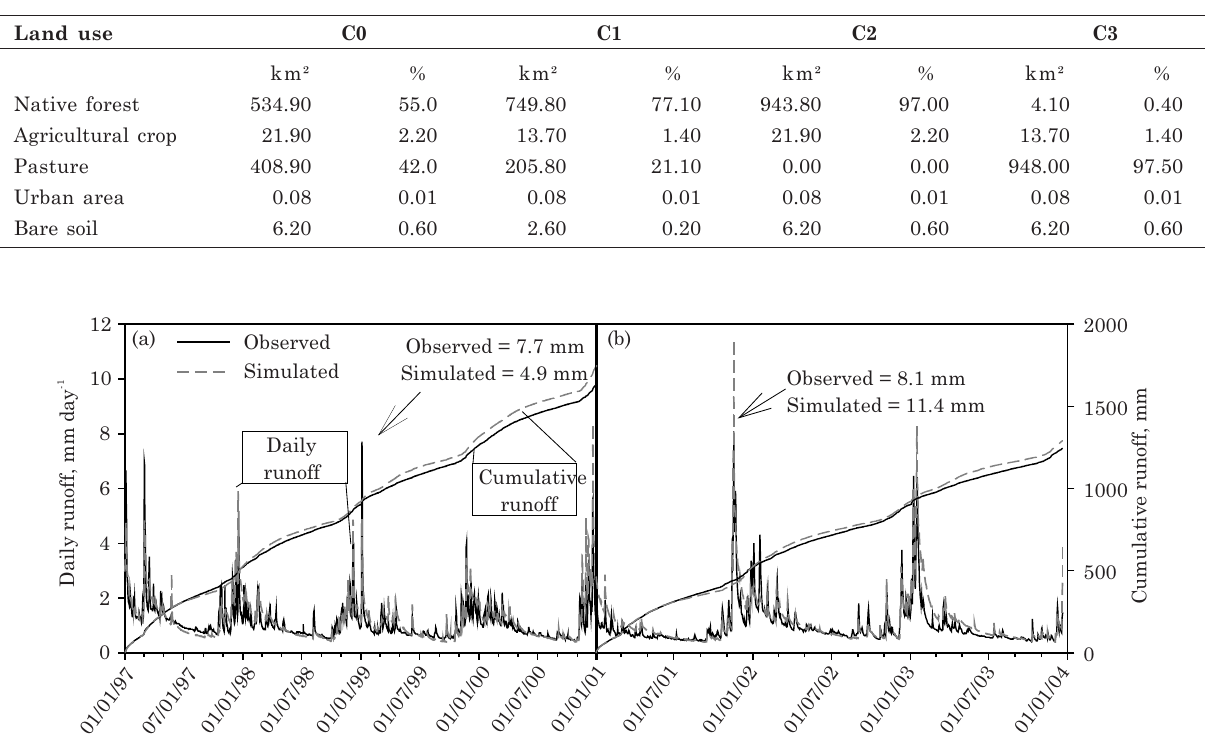
Figure 3. Hydrographs of observed and SWAT-simulated daily and cumulative runoff in the Galo creek watershed in periods (a) of calibration, from Jan. 1 st , 1997 to Dec. 31, 2000, and (b) of validation, from Jan. 1 st , 2001 to Dec. 20, 2003.